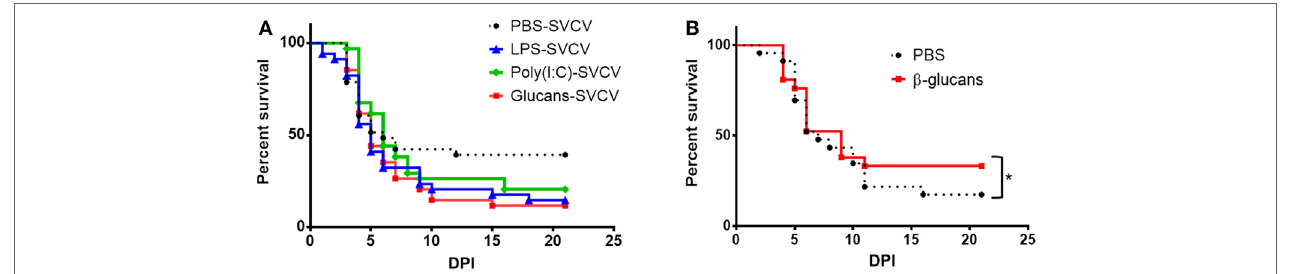
FigUre 4 | Effect of pathogen-associated molecular patterns (PAMPs) on the survival of adult zebrafish after a Spring Viremia Carp Virus (SVCV) challenge. (a) Kaplan–Meier survival curves after an SVCV i.p. challenge. Fish were stimulated with PAMPs or inoculated with phosphate-buffered saline (PBS), and 35 days after a single-dose administration, they were i.p. challenged with SVCV. No significant differences were observed among the different groups, although the PAMP-treated zebrafish showed a lower survival rate. (B) Kaplan–Meier survival curves after SVCV i.p. challenge. Fish were previously inoculated with β -glucans or PBS and i.p. challenged with SVCV 7 days after a single-dose administration. A slight but significant increase in the survival rate was observed in fish that were previously treated with β -glucans. Significant differences are represented by asterisks (* p <